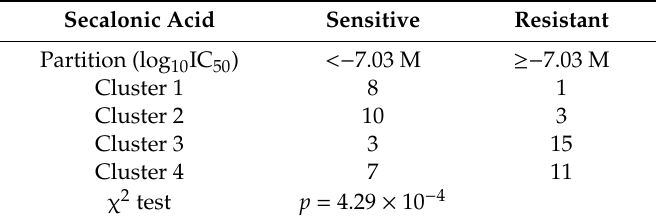
Figure 5. Dendrograms and heatmap of secalonic acid obtained by hierarchical cluster analyses of the NCI cell line panel and genes whose mRNA expression is directly or inversely correlated with the log 10 IC 50 values for secalonic acid. The red frames on the dendrogram show the clustering of cell lines and the dendrogram on the top shows the clustering of genes. Table2.